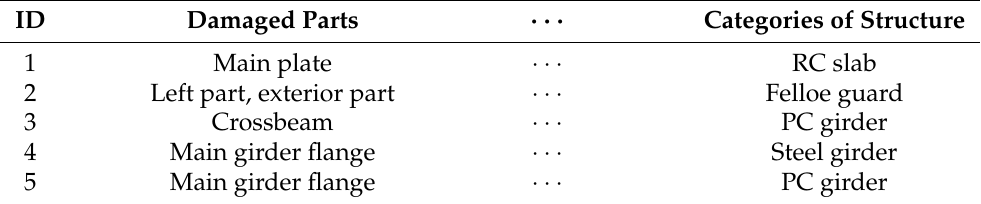
Table 1. Examples of text data. Each ID corresponds to one distress